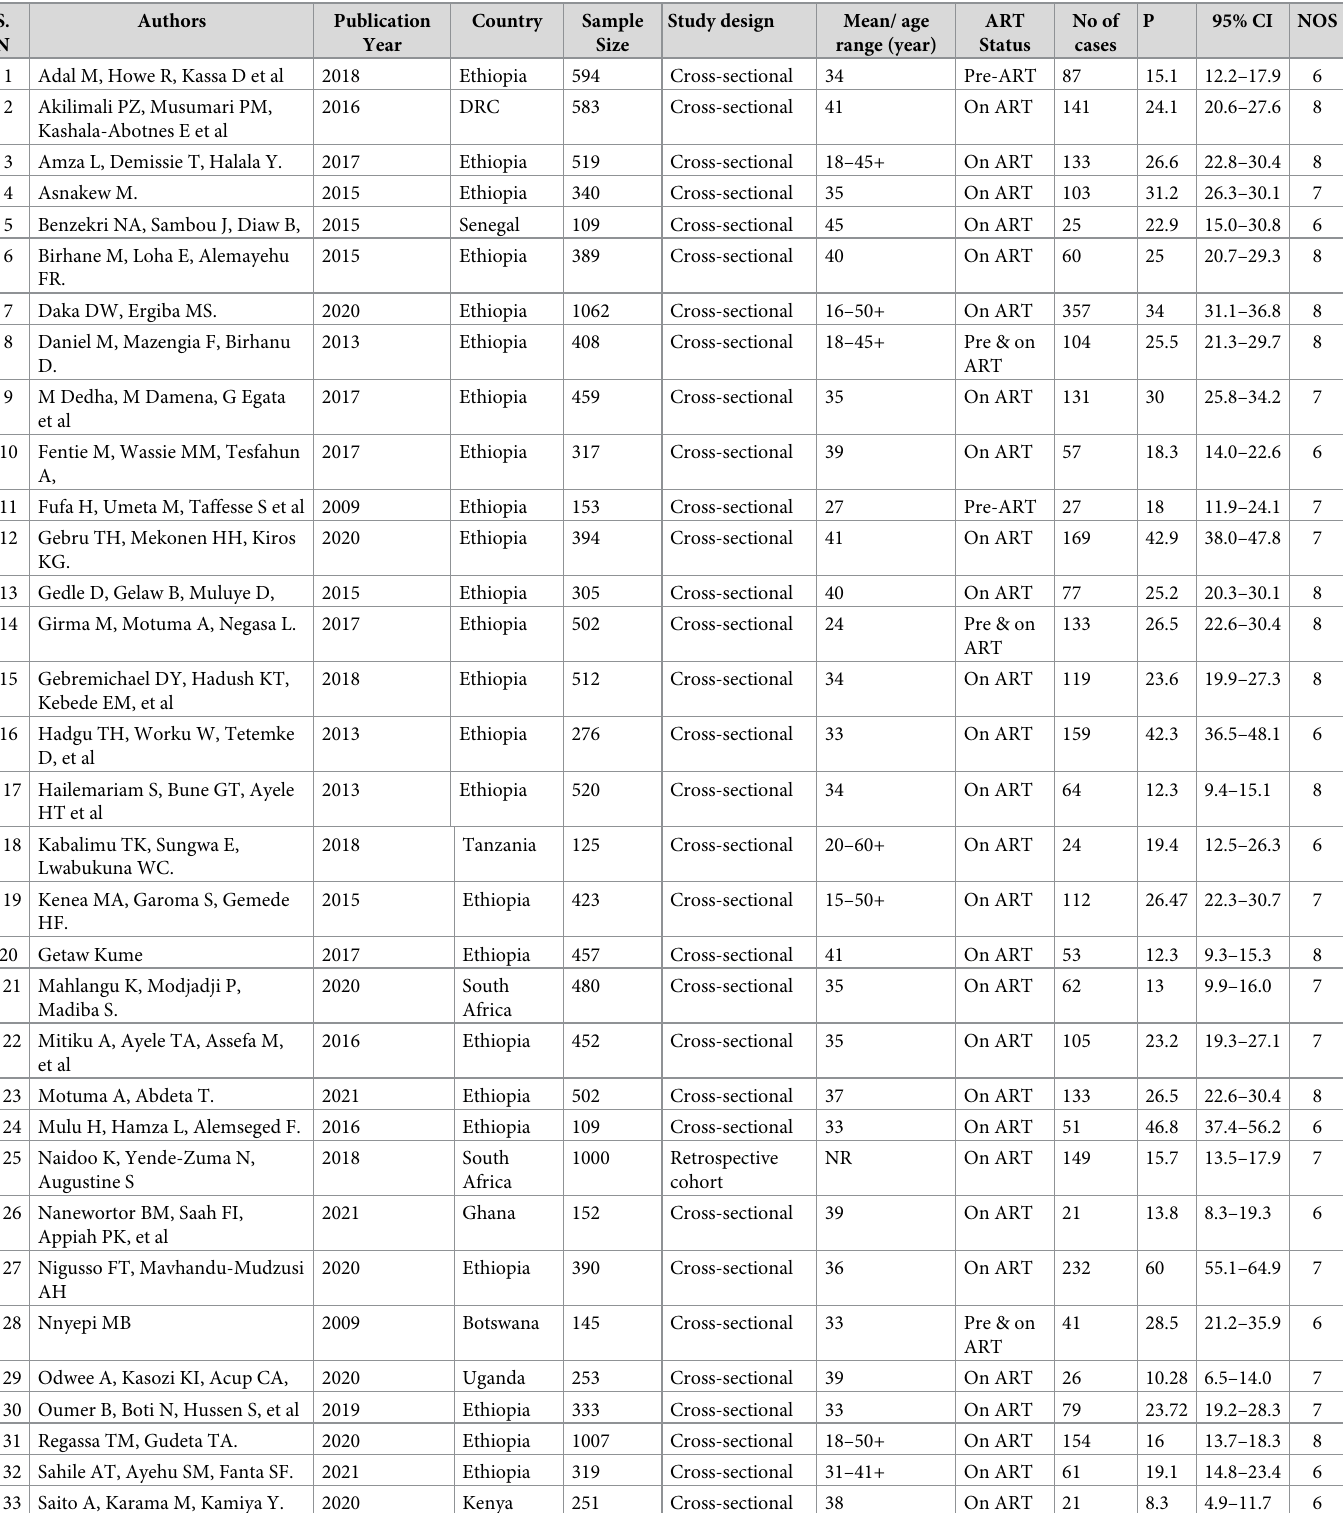
Table 2. Study characteristics included in meta-analysis of undernutrition among adult PLWHIV in sub-Saharan Africa, 2009–2021. S.